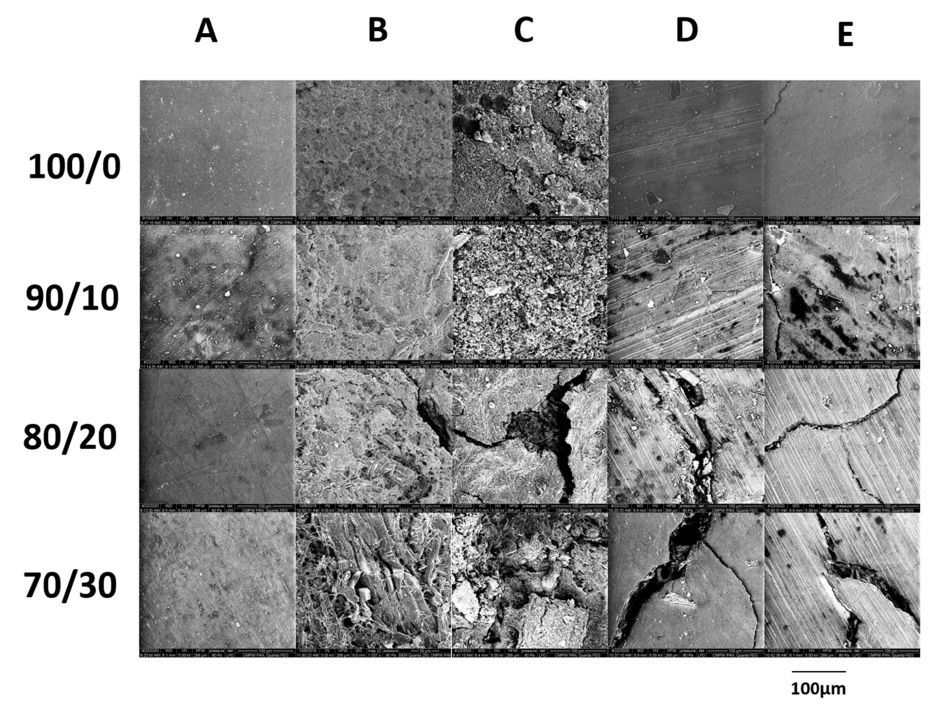
Figure 1. SEM micrographs of the neat P(3HB- co -4HB) (100/0) and P(3HB- co -4HB)/WF composites / 10, 80 / 20, and 70 / 30, before ( A ) and after 21 days of degradation in BIODEGMA ( B ), with the mass ratio of 90/10, 80/20, and 70/30, before ( A ) and after 21 days of degradation in the mass ratio of 90 Respirometer ( C ), water ( D ), and bu ff er ( E ). (Original SEM photos in the Supplementary Material Figure